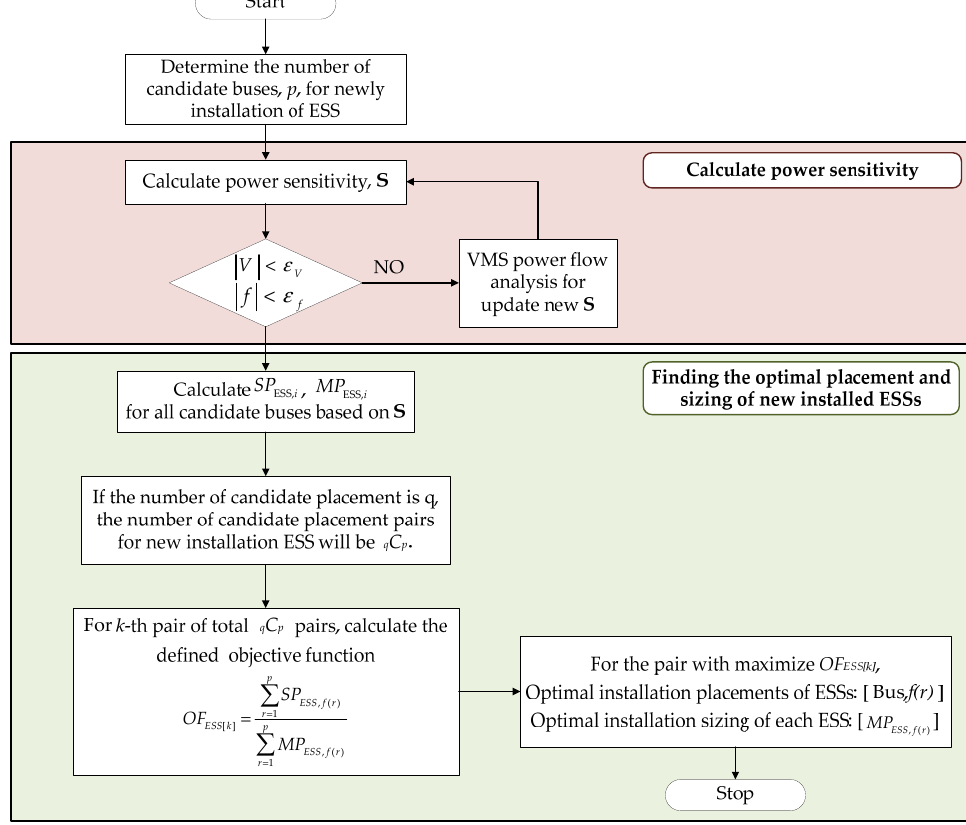
Figure 1. Flowchart for the optimal placement and sizing of a newly installed ESS based on the power sensitivity analysis. Table 1. Comparison to other ESS installation